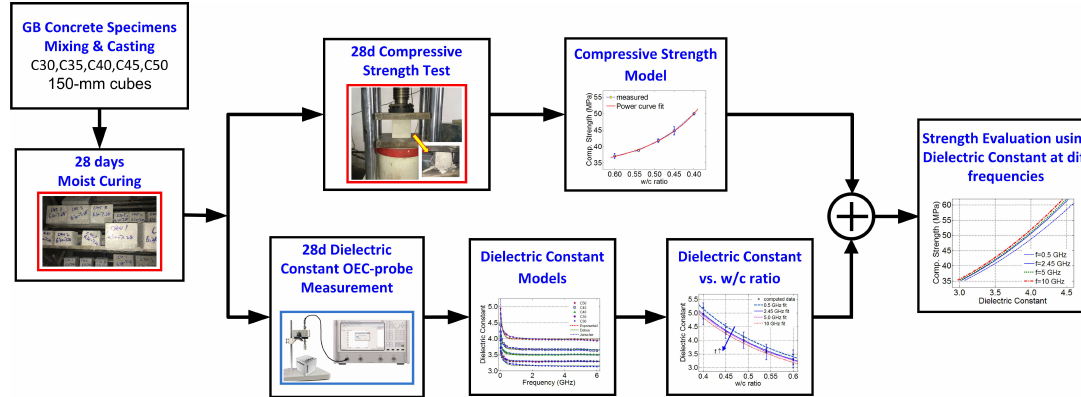
Figure 1. A big picture illustrating the cross-disciplinary work for compressive strength evaluation, using the dielectric constant of 28-day cement